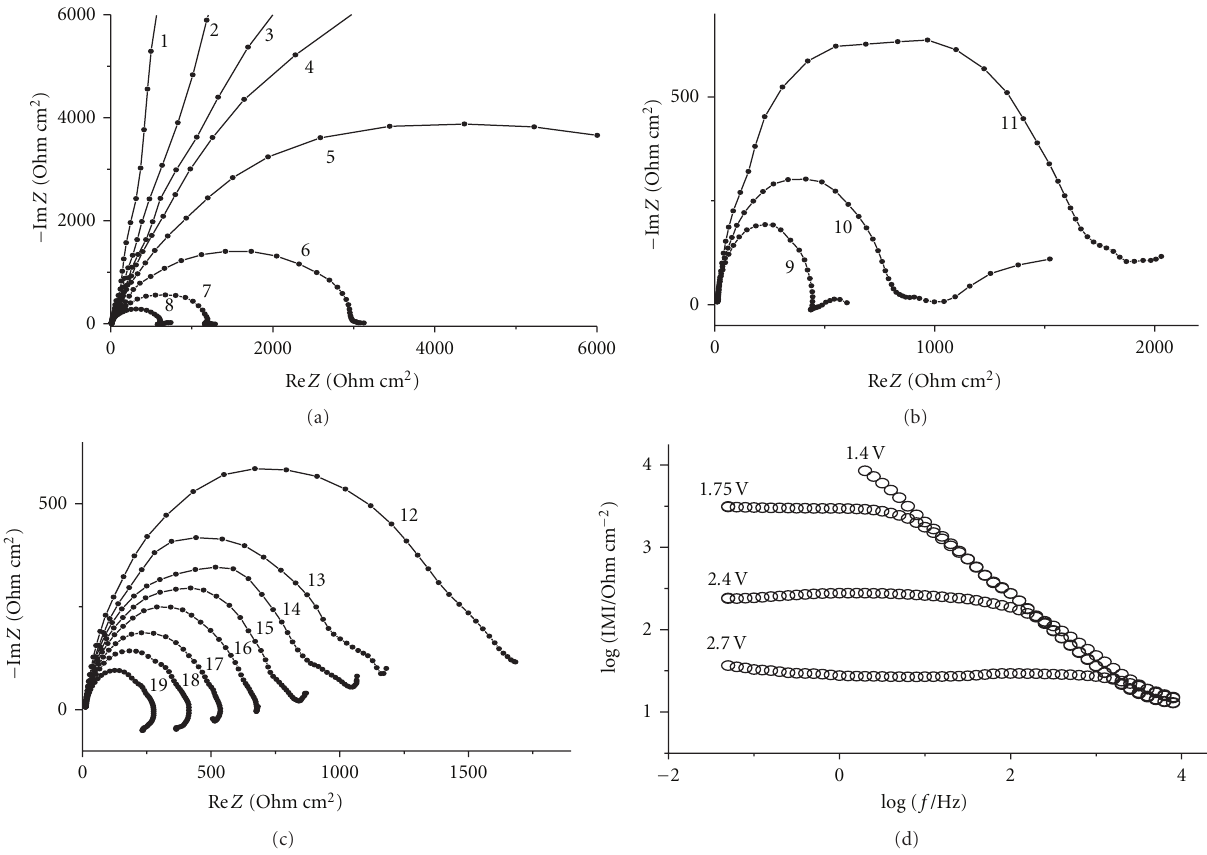
Figure 4: (a)–(c) Complex-plane plots of impedance spectra ( f -sweep) in 0.5 M K 2 SO 4 benzene-saturated solution at potentials E : (1) 0.80V; (2) 1.40 V; (3) 1.60 V; (4) 1.65 V; (5) 1.70 V; (6) 1.75V; (7) 1.80 V; (8) 1.85 V; (9) 1.90 V; (10) 1.95 V; (11) 2.00 V; (12) 2.05V; (13) 2.10V; (14) 2.15 V; (15) 2.20 V; (16) 2.25 V; (17) 2.30 V; (18) 2.35 V; (19) 2.40 V. (d) The Bode plot (bi-logarithmic dependence of the impedance modulus on the frequency).